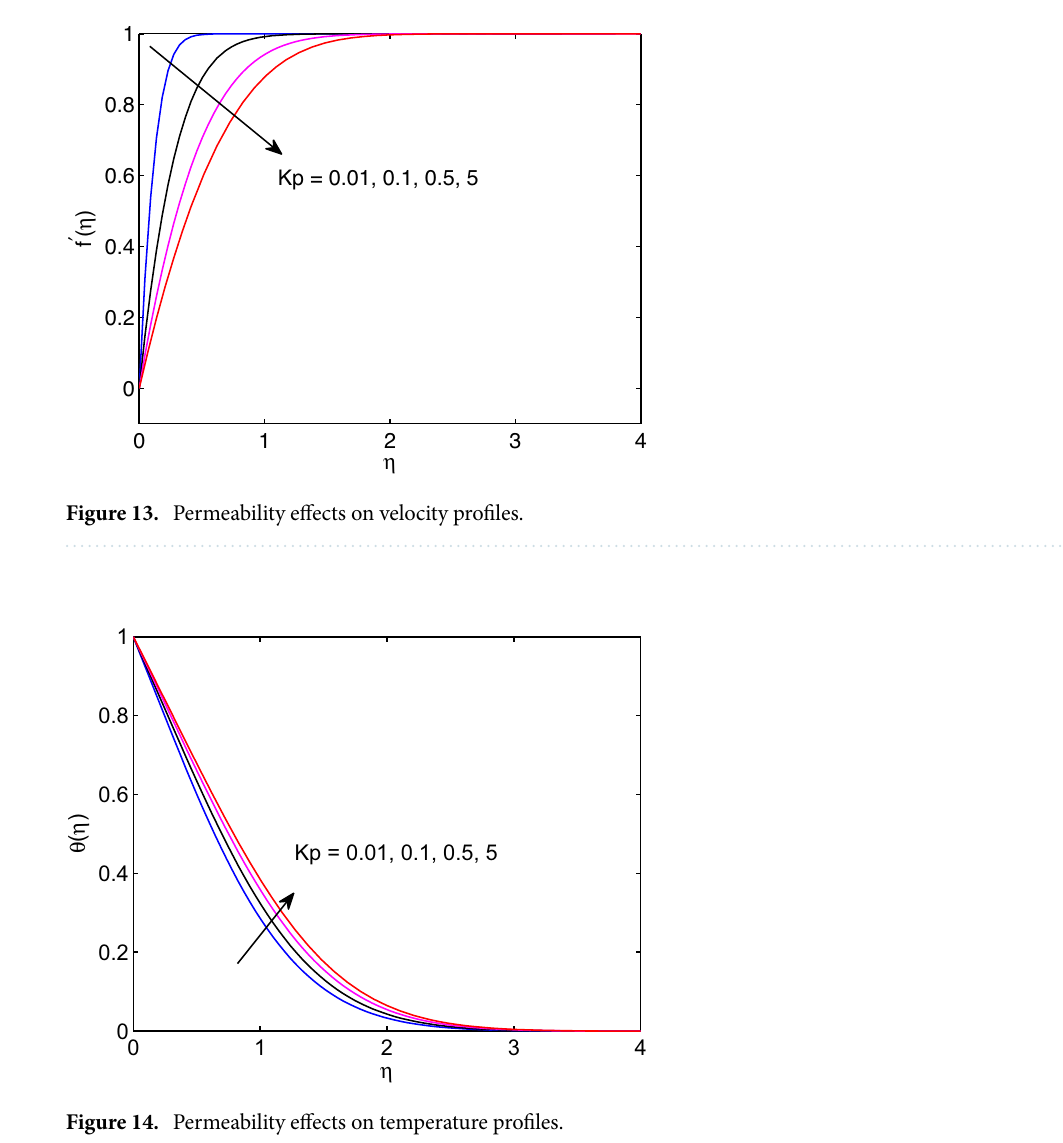
Fig. 13. This is due to hyperbolic tangent fluid velocity meets external velocity in a while for the larger values of permeability. The opposite approach of permeability effect on hyperbolic tangent nanofluid flow is analogous to the earlier impacts of magnetic field parameter on the flow problem. In addition, enlargement of permeability yields the increment of both temperature distribution and volumetric concentration (see Figs. 14 and 15). Fig. 16 explores influence of wedge angle parameter on tangent hyperbolic nanofluid velocity. Here, augment- ing wedge angle parameter produces an enhanced forced convection. This also in turn gives more hyperbolic tangent nanofluid velocity through the boundary layer. Hence, as wedge angle parameter augments, the hyper- bolic tangent fluid velocity increases. In addition, the thickness of momentum boundary layer reduces with the increment of wedge angle parameter. Prandtl number is a non-dimensional quantity occurs in the study of the dynamics of viscous fluids. It can be described as the quotient of viscous force or kinematic viscosity to the nanofluid thermal diffusivity. In this line, it measures the relative significance of heat conductivity and fluid viscosity and varies from one fluid to the other by its numerical values. Its effects on fluid temperature distribution and volumetric concentration of the fluid are disclosed in Figs. 17 and 18. Here, both temperature and nanoparticle concentration of the tangent hyperbolic nanofluid including their boundary layer thicknesses diminish with the increment of Prandtl number.